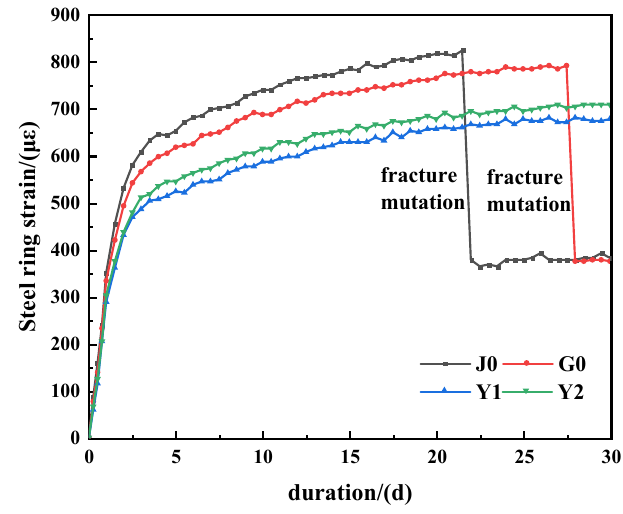
Figure 4. The strain value of the steel ring.